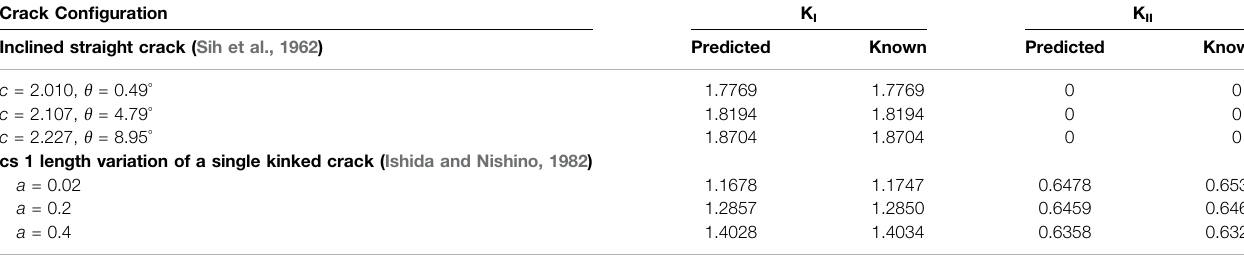
TABLE 2 | Validation of SIF predicted values for an inclined straight crack SIF and a single kinked crack (speci fi cally the crack tip of segment 1) with known values. Crack Con fi guration K I Inclined straight crack (Sih et al., 1962)